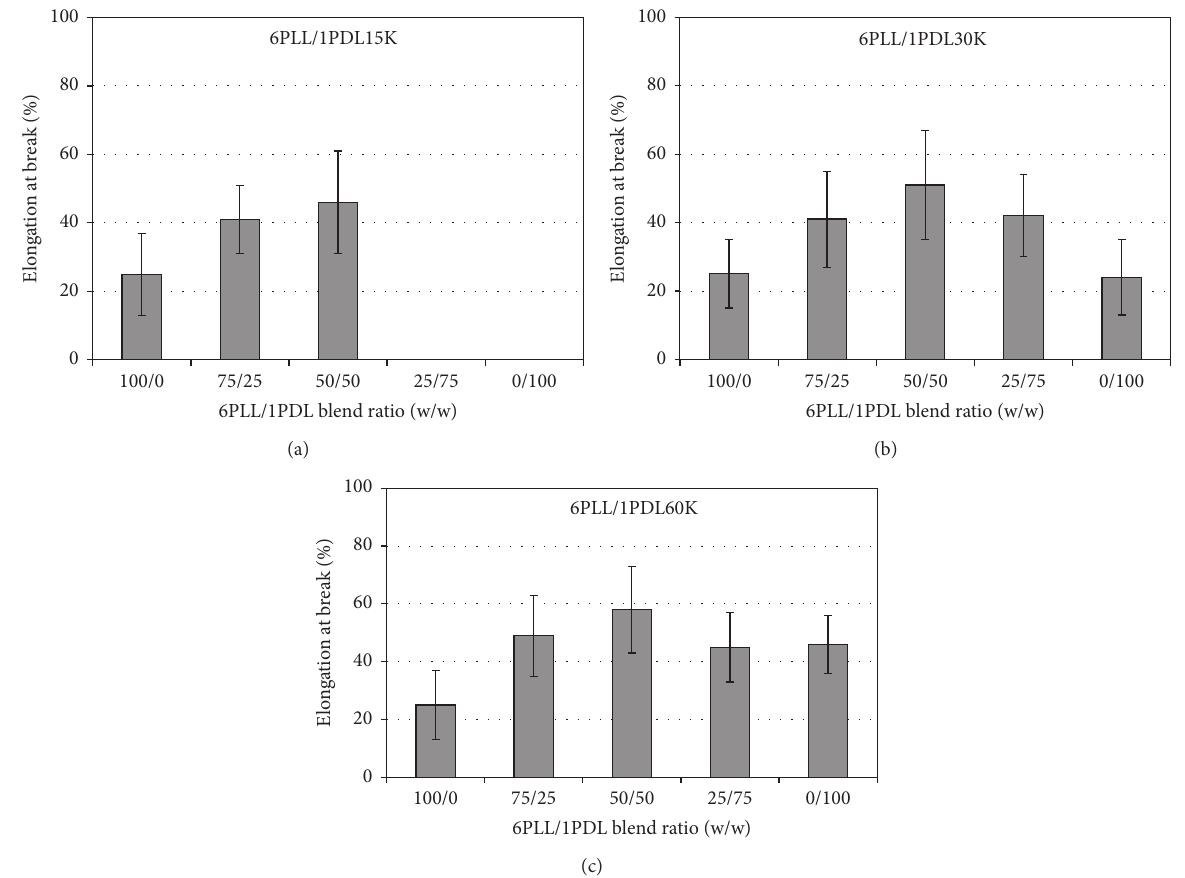
Figure 6: Elongation at break of 6PLL, 1PDL, and 6PLL/1PDL stereocomplex films prepared with different 1PDL molecular weights and 6PLL/1PDL blend